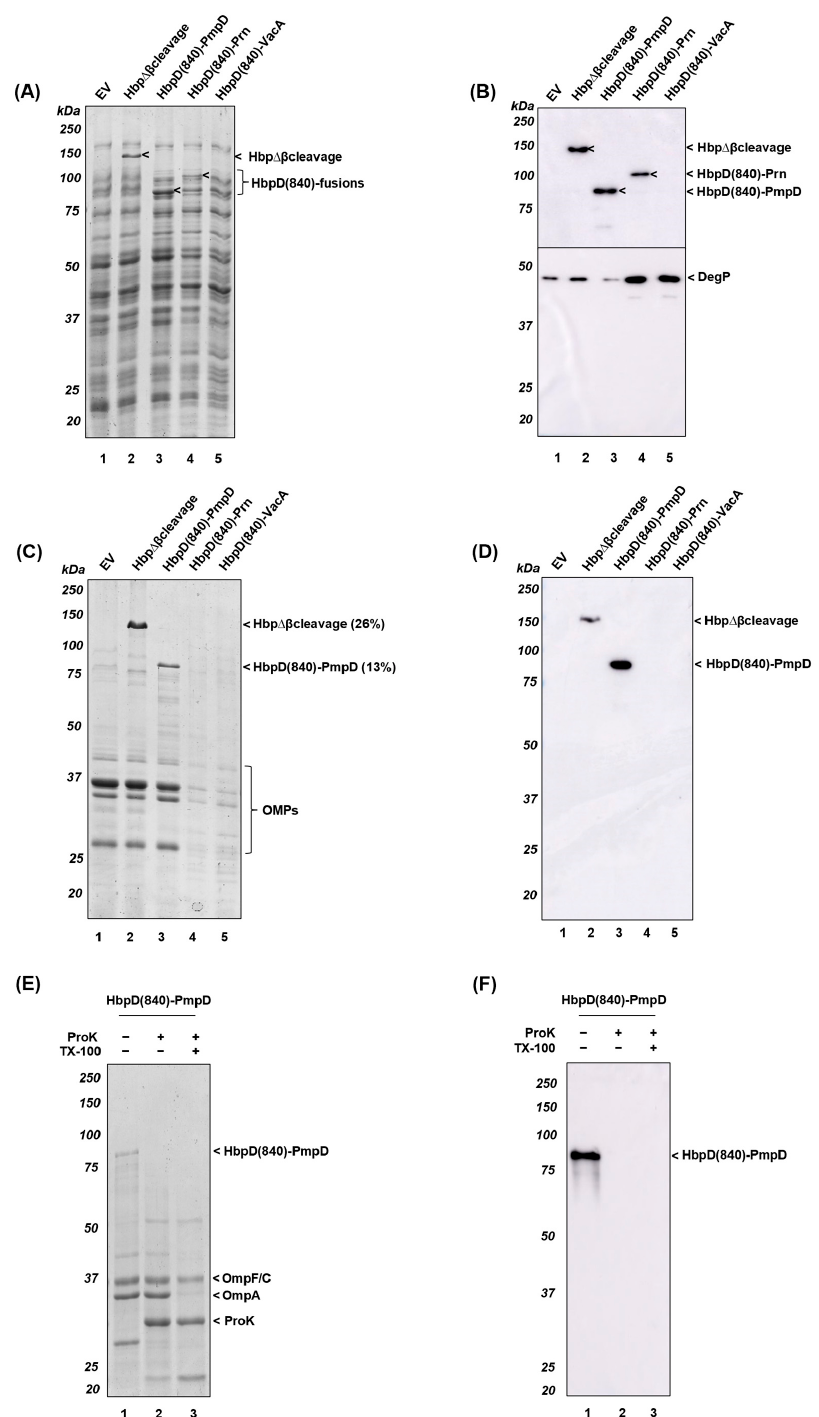
Figure 5. Expression of EV, Hbp ∆ β cleavage, HbpD(840)-PmpD, HbpD(840)-Prn and